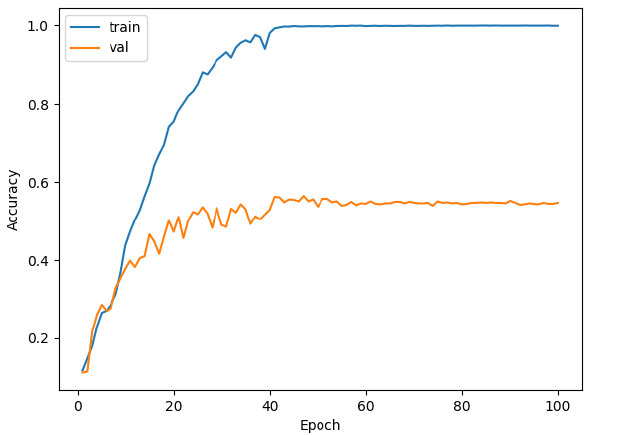
Figure 11. The accuracy of DEMON and LeNet (54%).